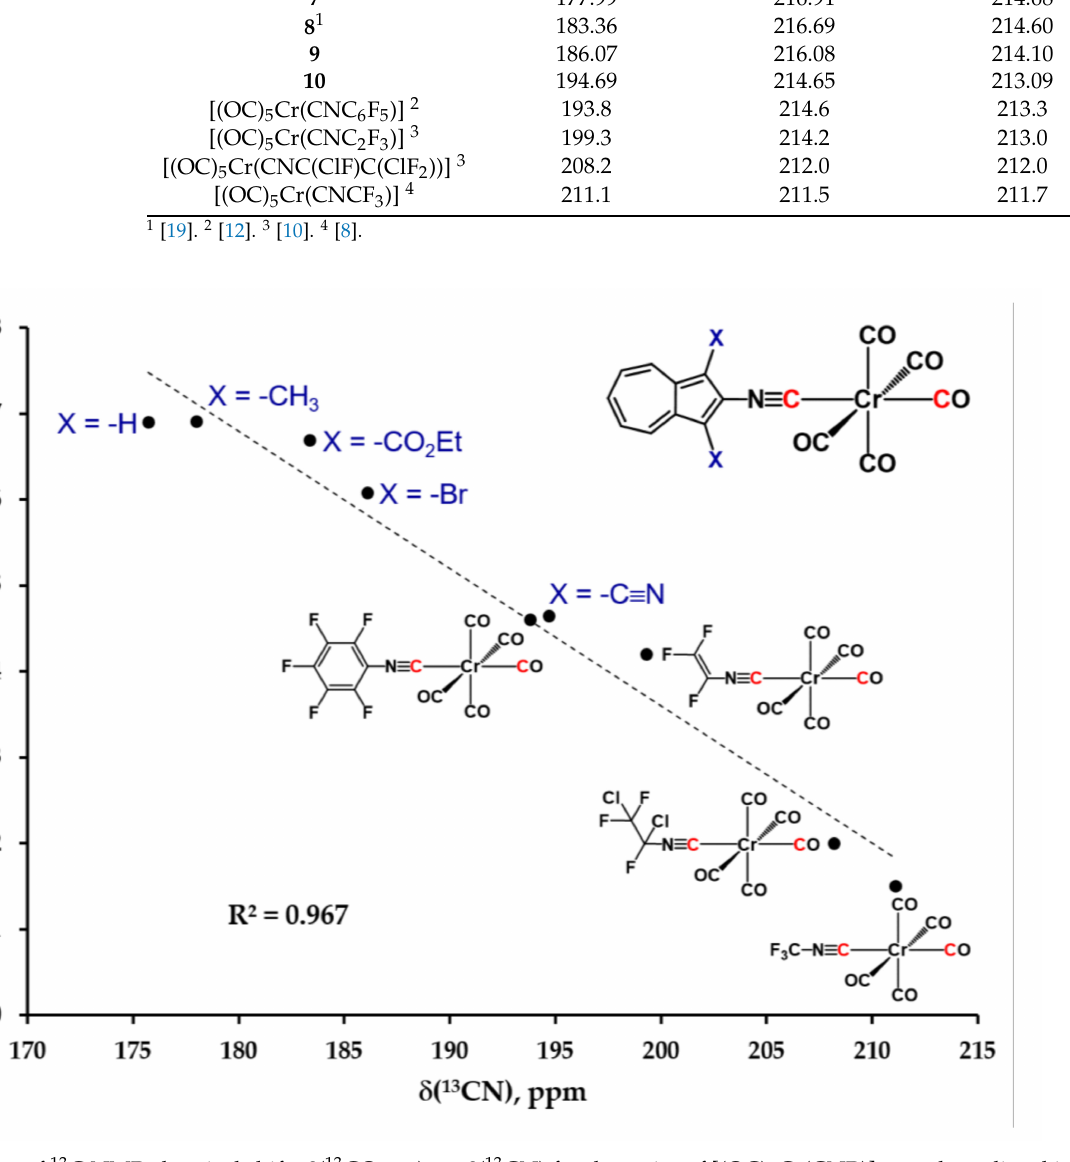
Figure 10. Plot of 13 C NMR chemical shifts δ ( 13 CO trans ) vs. δ ( 13 CN) for the series of [(OC) 5 Cr(CNR)] complexes listed in Table 5. All 13 C NMR data were collected for solutions in CDCl 3